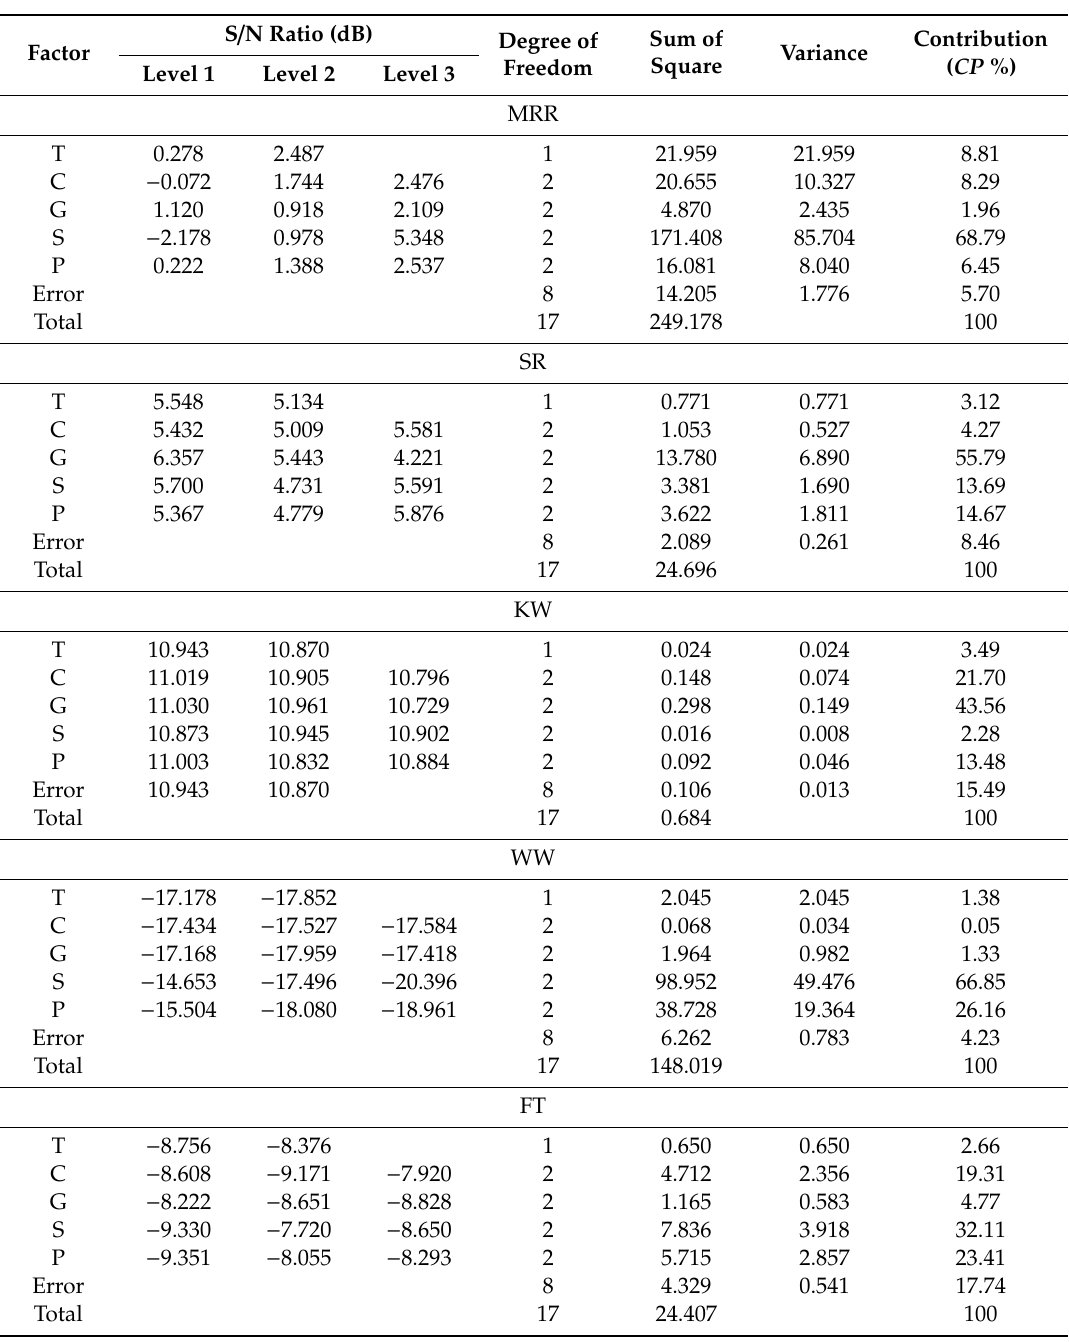
Table 4. ANOVA for multiple quality characteristics.